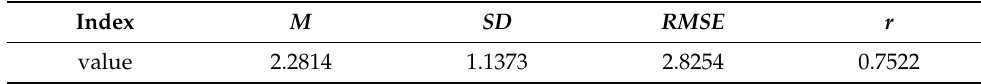
Table 1. Statistical results of